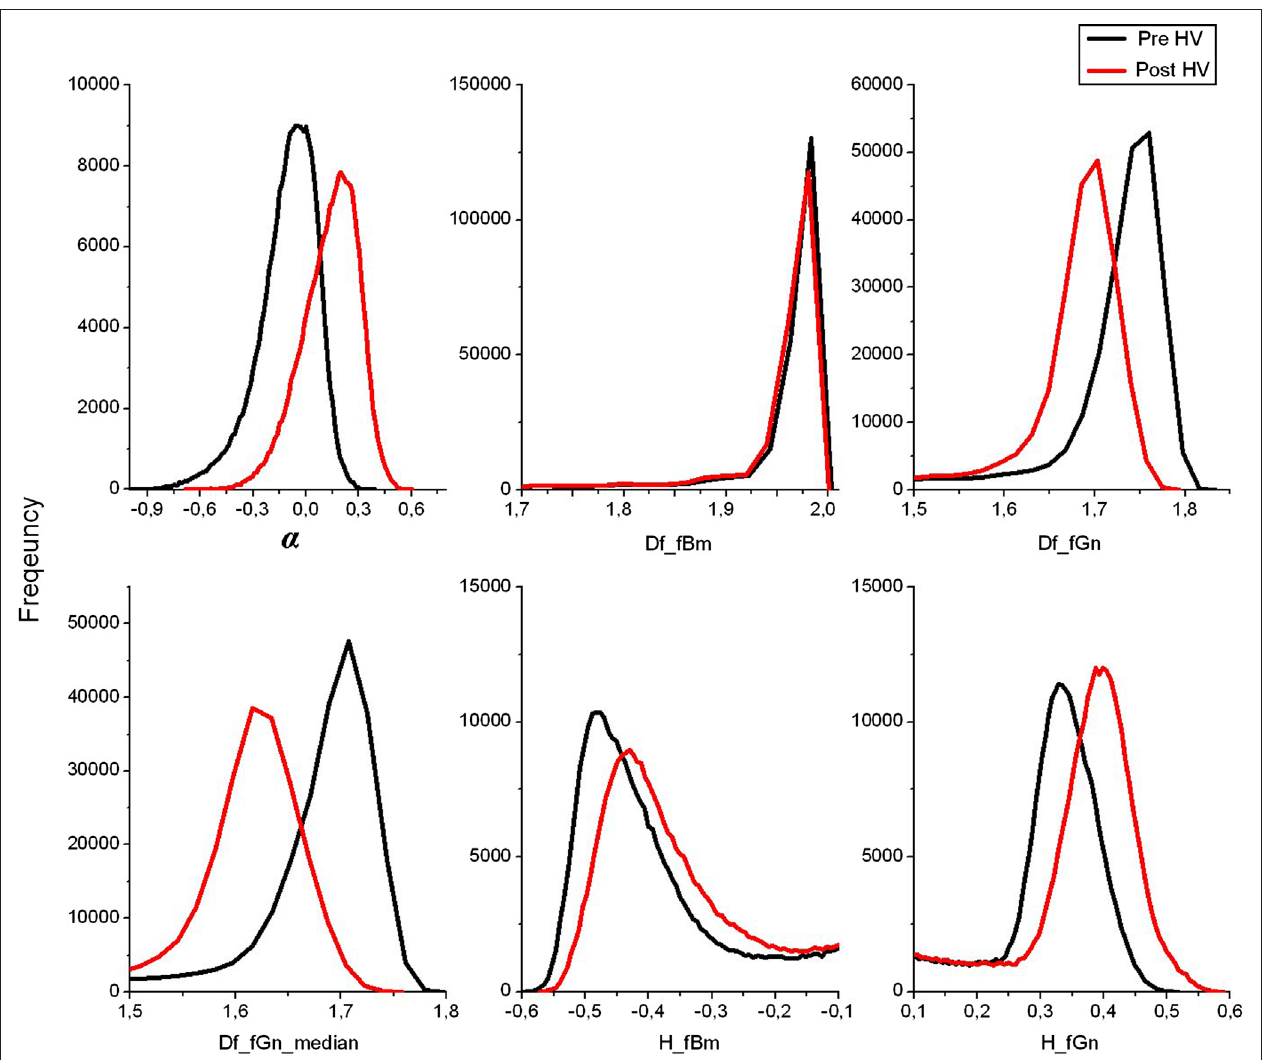
FIGURE 2 | Group mean histograms of α , D